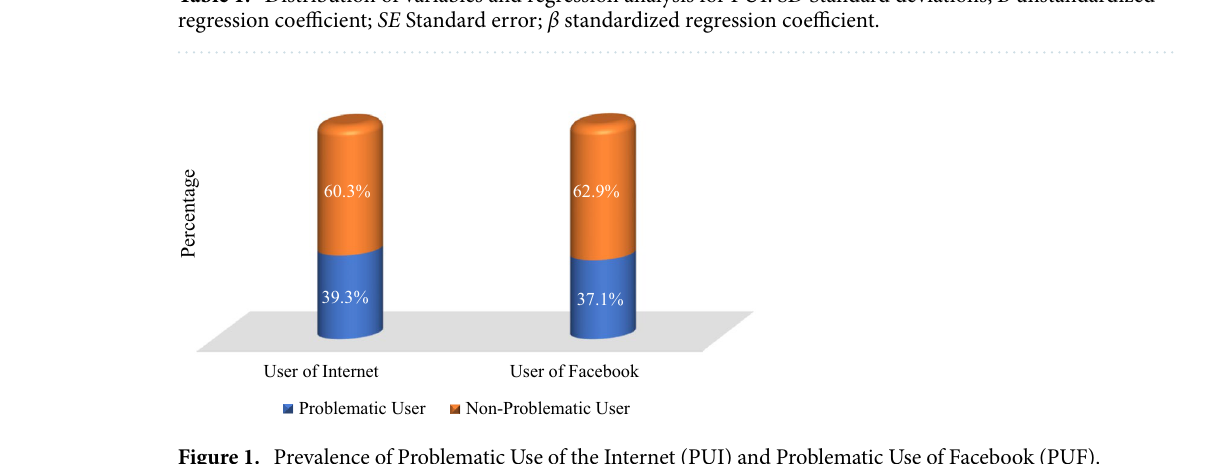
Figure 1. Prevalence of Problematic Use of the Internet (PUI) and Problematic Use of Facebook